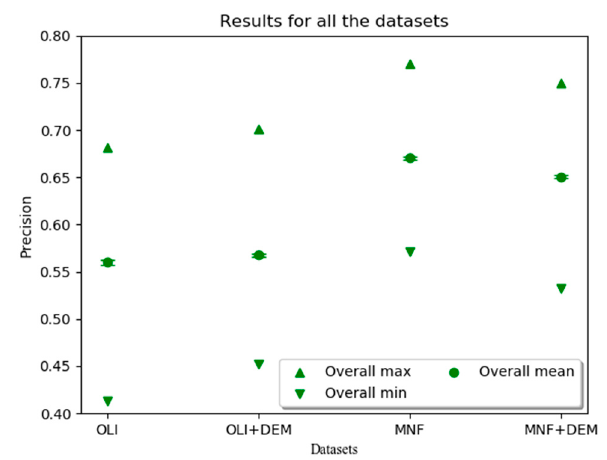
Figure 7. Precision obtained for each input dataset considering all the different model configurations as a whole. “Overall max” is the highest precision obtained. “Overall mean” is the mean precision obtained with its standard deviation. “Overall min” is the lowest precision obtained.